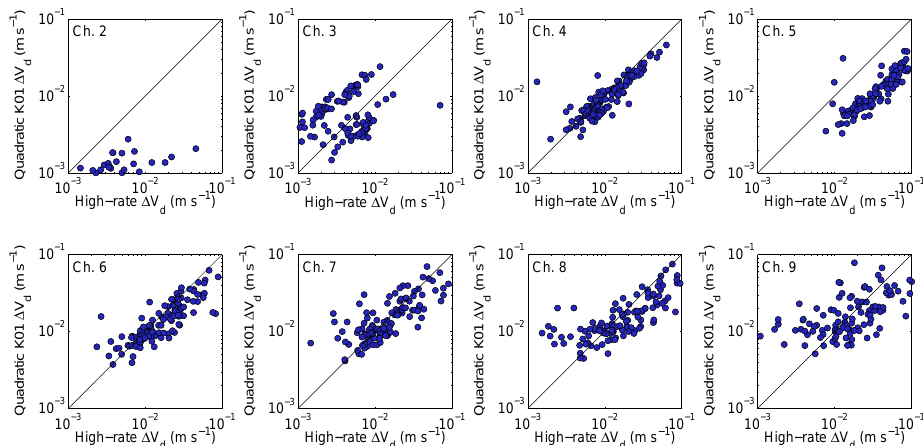
Fig. 12. Scatterplots showing the relationships between high-rate 1v d and K01 (modified to use a log-linear quadratic fit) 1v d in Fig. 11.